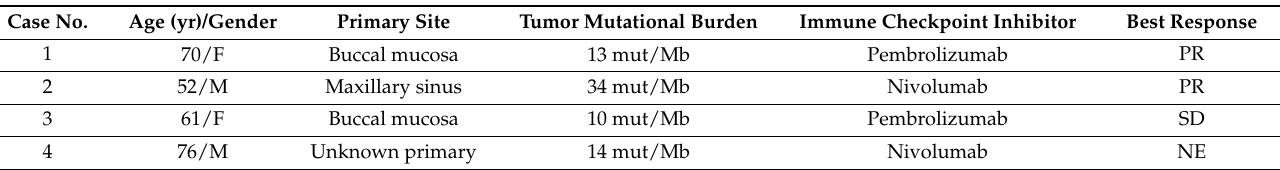
Table 3. Clinical characteristics of patients with